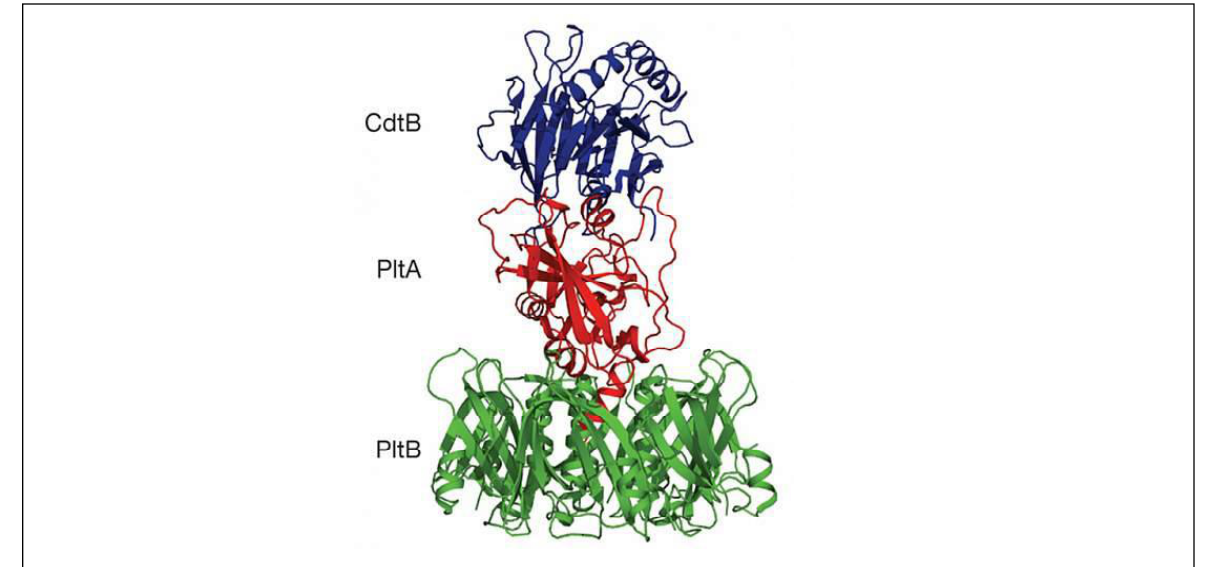
Figure 2: Complex of typhoidal toxin showing the 2 A subunits (blue and red) and 5 B subunits (green) (Song et al .,